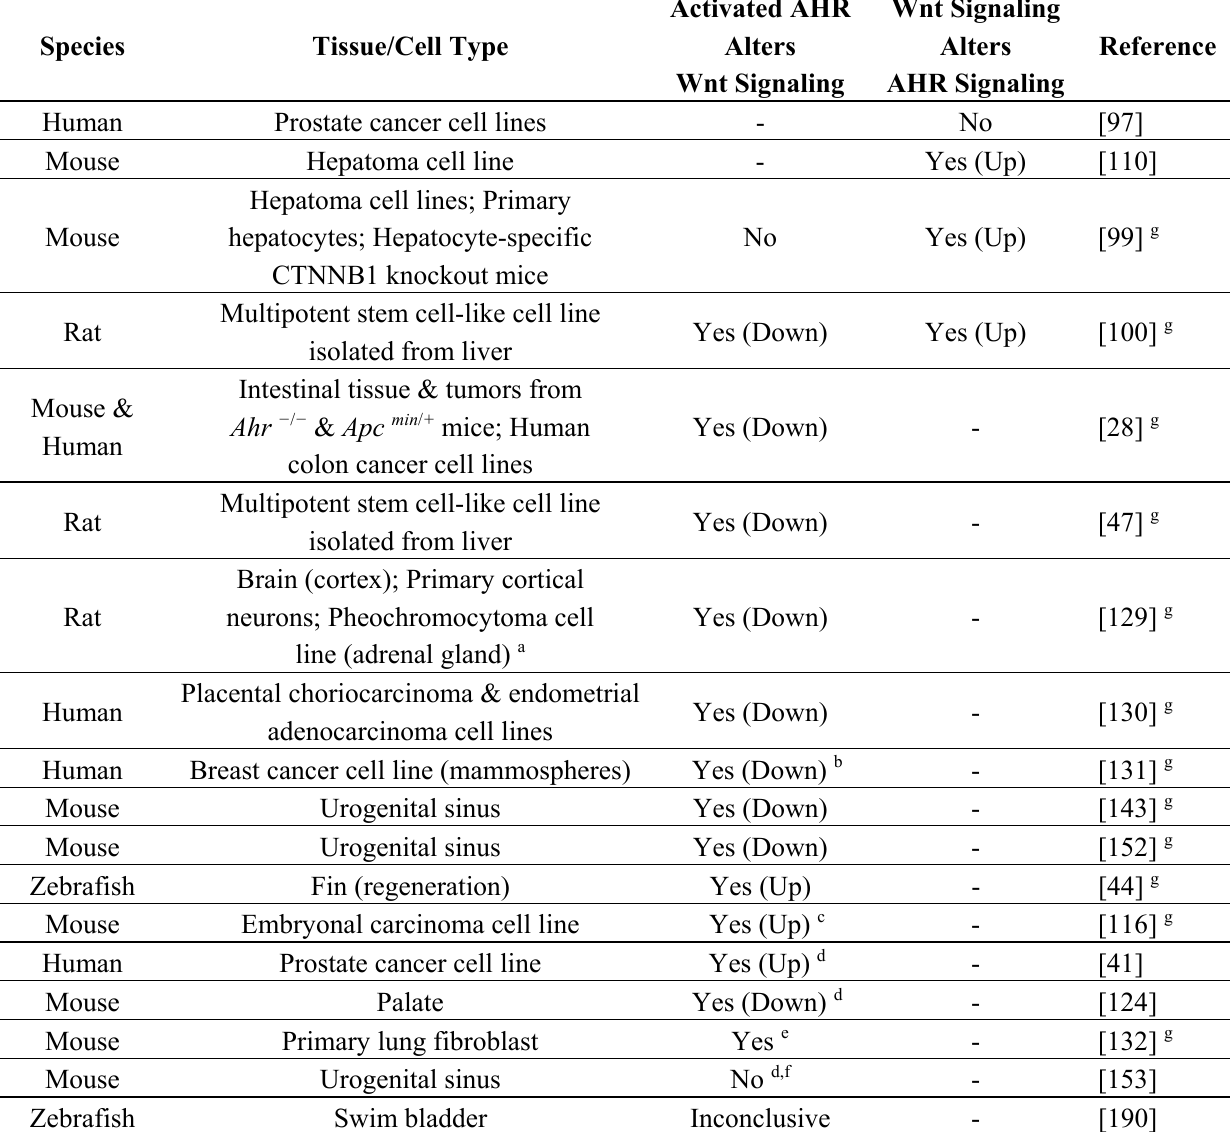
Table 1. Intersection of AHR and Wnt